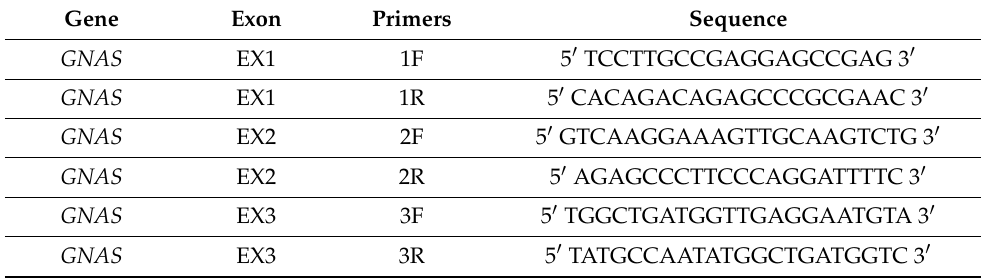
Table 1. Primers used for the amplification and analysis of the GNAS